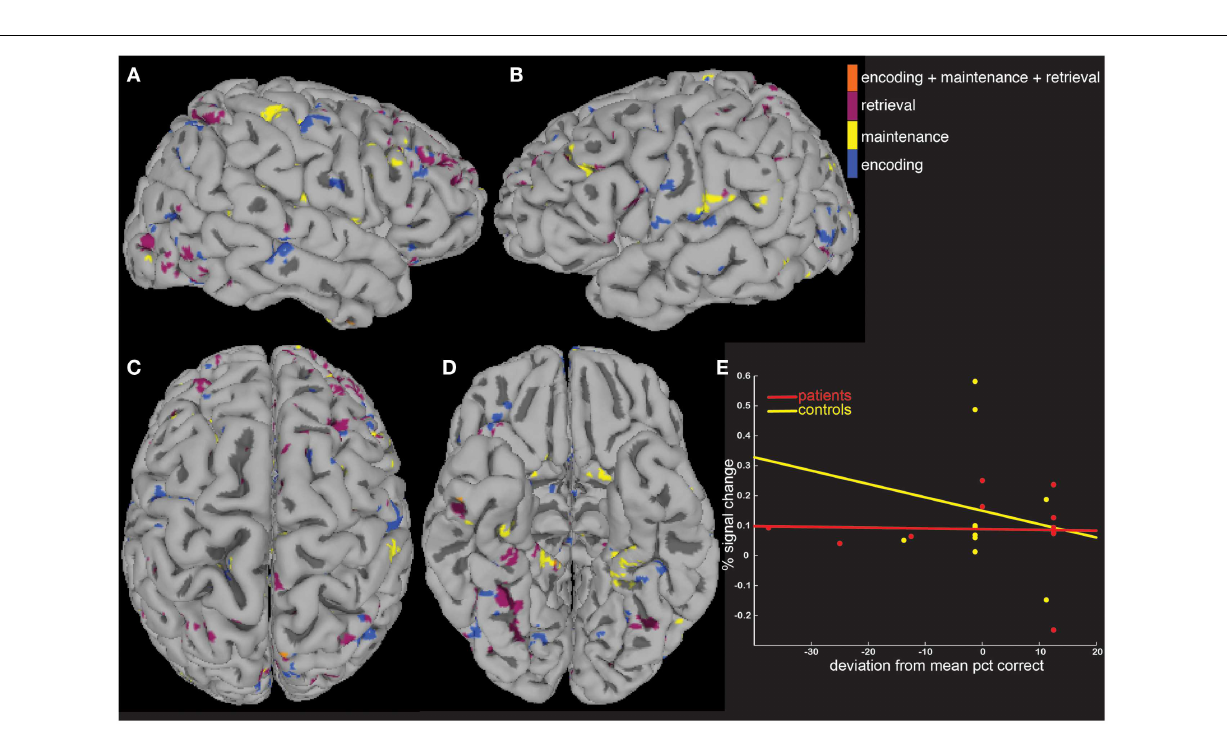
FIGURE 5 |A covariate interaction analysis shows regions that differ as a function of working memory accuracy . Several regions (A–D) exhibited fMRI activity that covaried significantly ( p < 0.05) differently between patients and controls as a function of working memory accuracy (E)